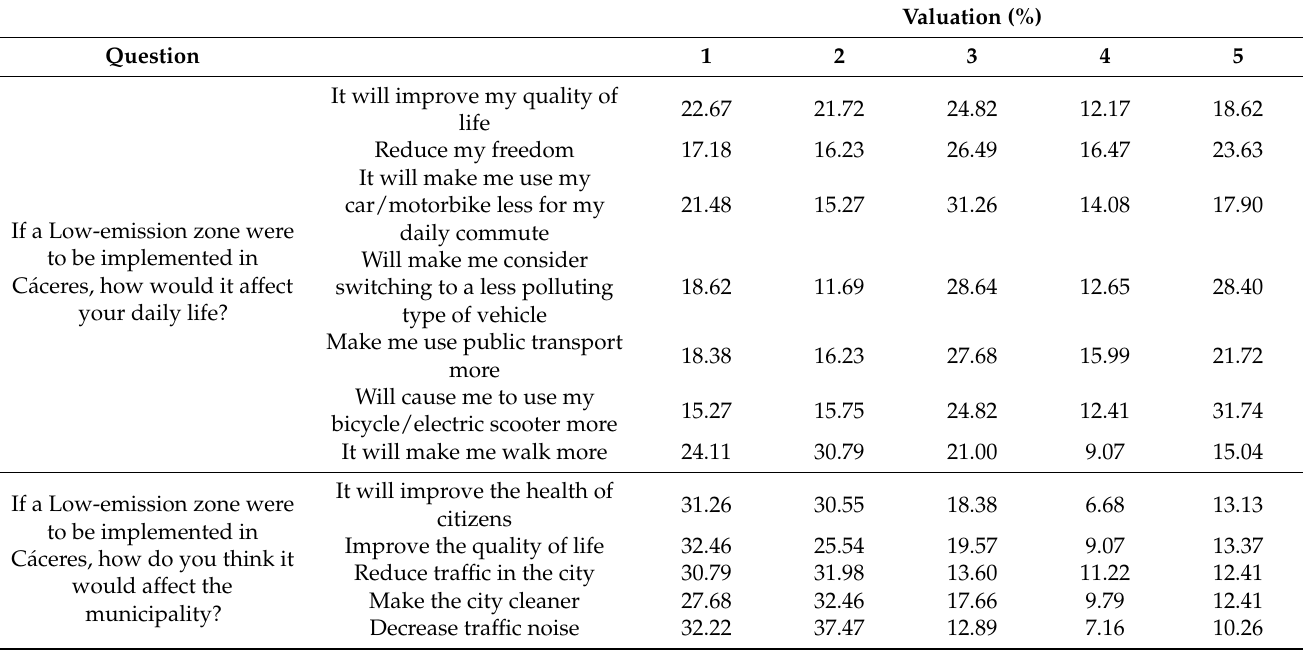
Table 7. Assessment of the possible implementation of an LEZ in C á ceres.